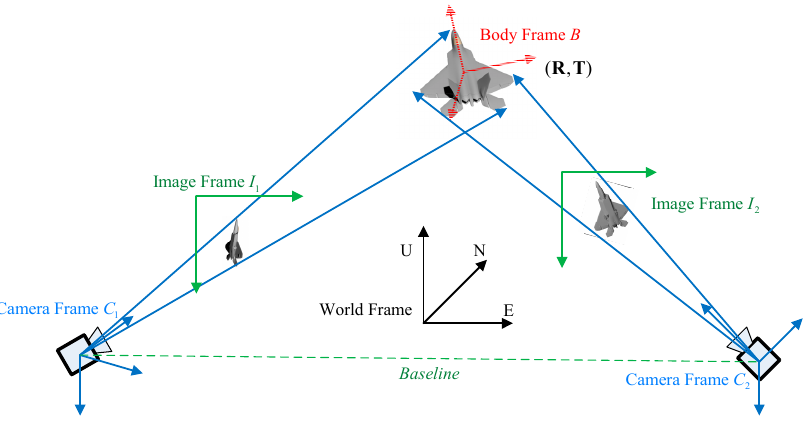
Figure 2. The schematic representation of the pose estimation problem.